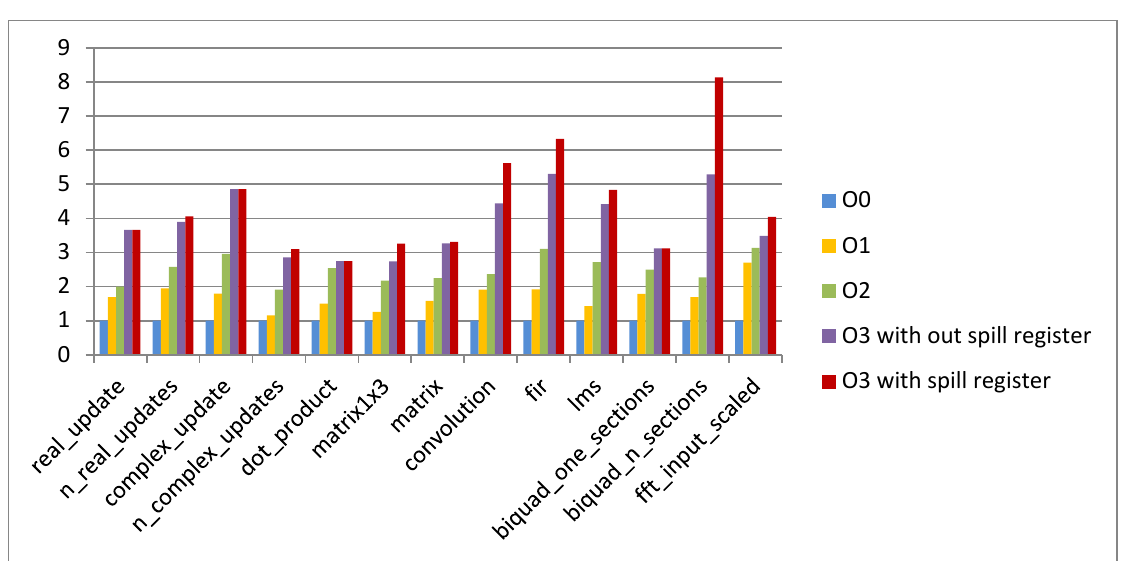
Figure 4. Performance